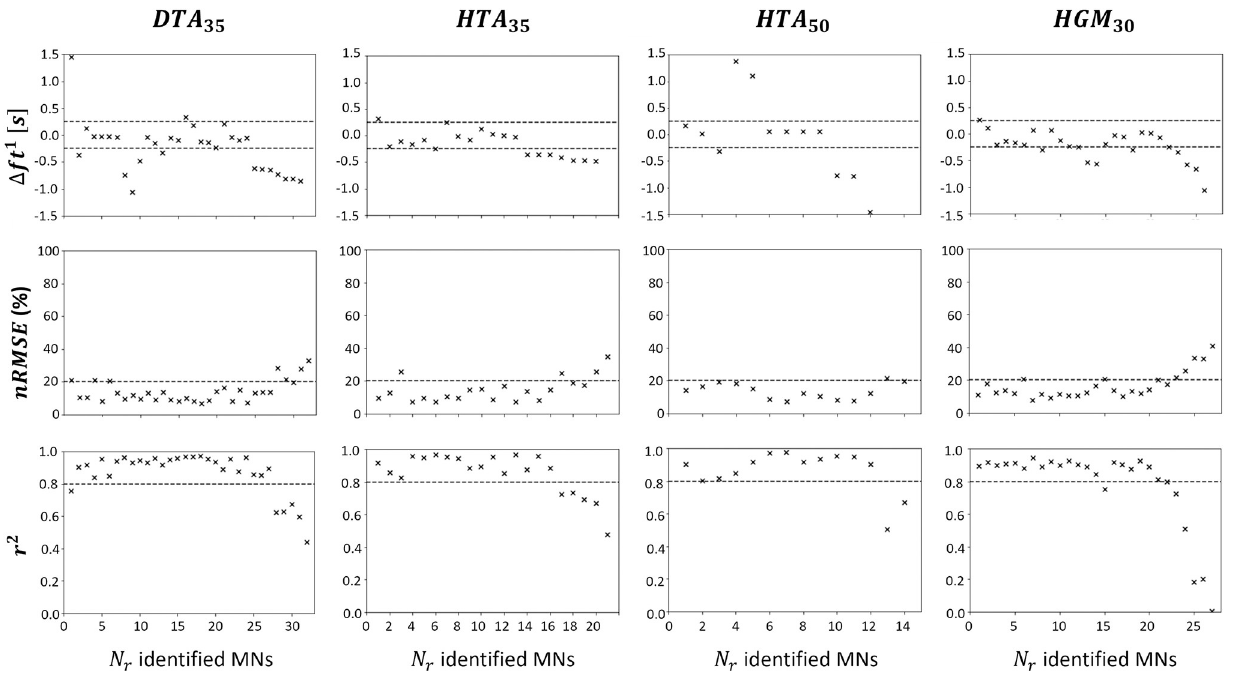
Fig 12. Validation of the MN recruitment and firing behaviour predicted with the 4-step approach (Fig 1) for the N r MNs experimentally identified in the four datasets DTA 35 , HTA 35 , HTA 50 and HGM 30 described in Table 1. For the validation of each i th predicted MN spike train, the experimental information of the i th identified MN was omitted when deriving the current input I ( t ) and the IP ( j ) and S ( j ) distributions (steps 2 and 3), from which the IP and S parameters are obtained without bias for the i th MN. The spike train sp sim i as input. The absolute error in predicting the experimental recruitment time D ft 1 Experimental and filtered instantaneous discharge frequencies FIDF exp nRMSE (%) and r 2 in the second and third rows of the figure. The dashed lines represent the Δ ft 1 2 [ − 250; 250] ms , nRMSE 2 [0; 15]% MVC and r 2 2 [0.8, 1.0] intervals of interest respectively.